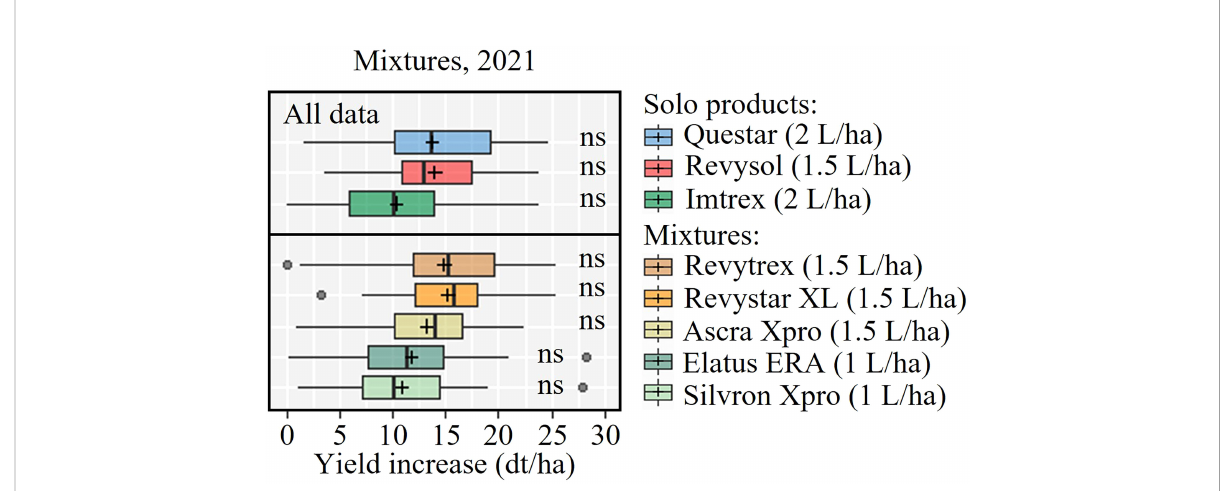
FIGURE 7 Yield increases from nine fi eld trials with Questar (fenpicoxamid), Revysol (mefentri fl uconazole), Imtrex ( fl uxapyroxad), Revytrex and Revystar ( fl uxapyroxad + mefentri fl uconazole), Ascra Xpro (bixafen + fl uopyram + prothioconazole), Elatus ERA (benzovindi fl upyr + prothioconazole) and